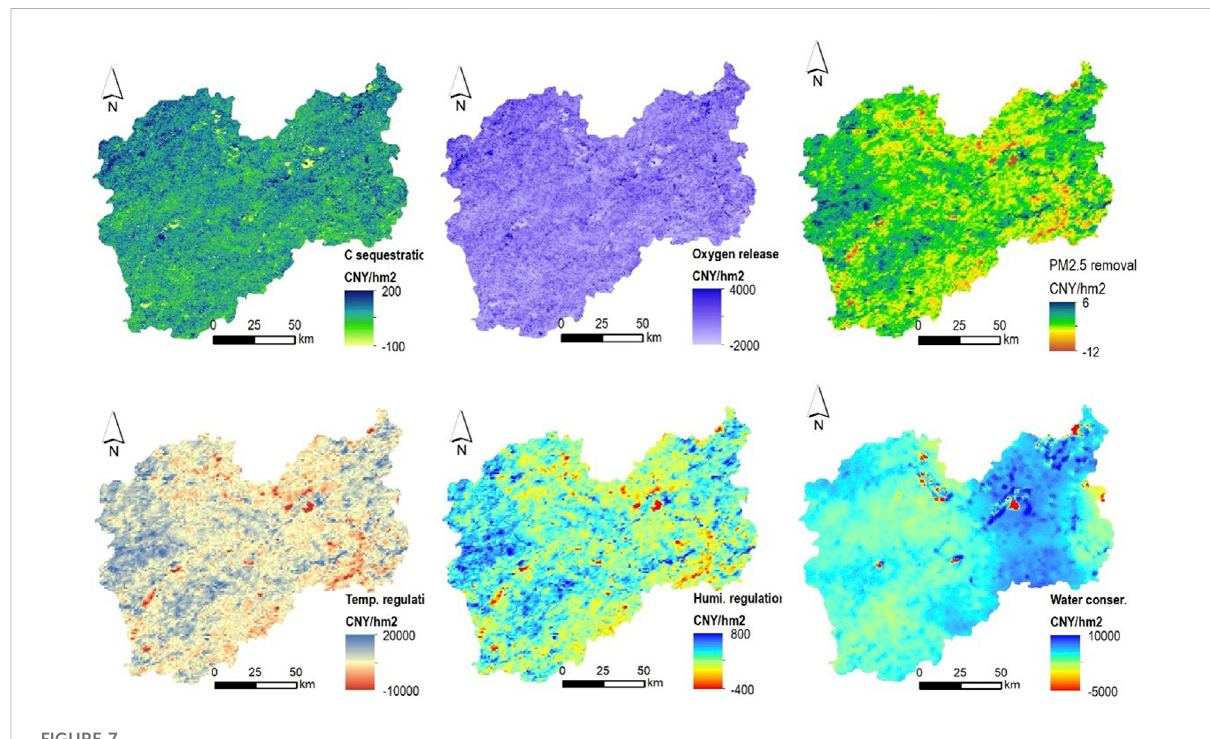
FIGURE 7 Change of ecosystem service value in